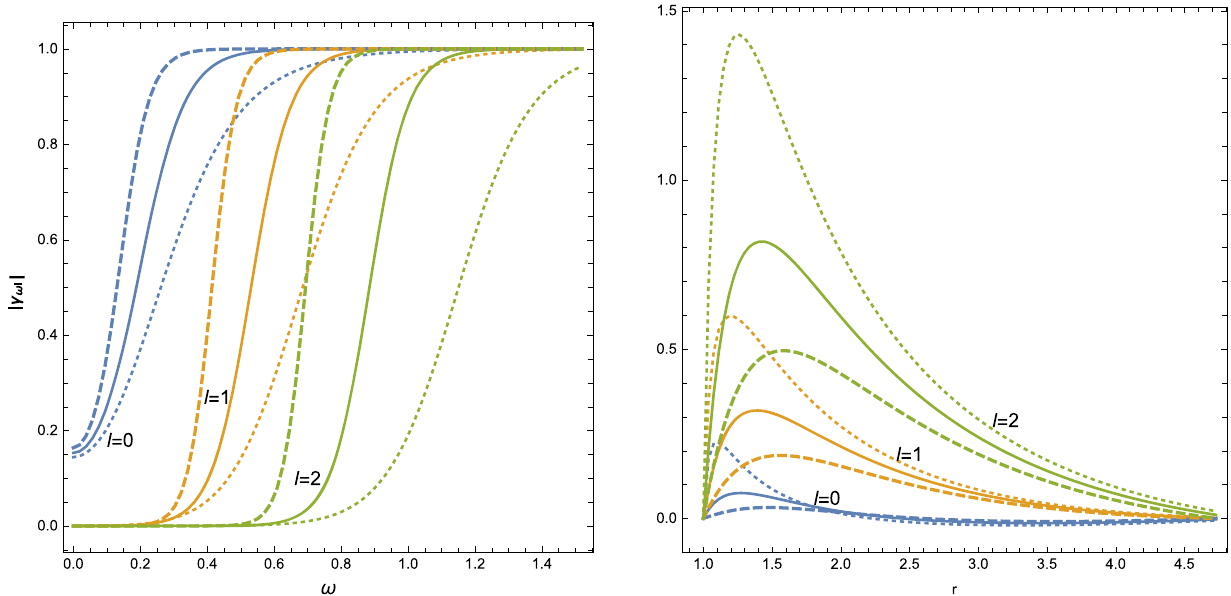
Fig. 2 Effects of α on the greybody factor for different modes l (left) and the corresponding effective potential (right). Dotted lines, solid lines and dashed lines denote α = − 0 . 3, α = 0 and α = 0 . 3, respectively. We fix (cid:3) = 0 . 1 and ξ = 0